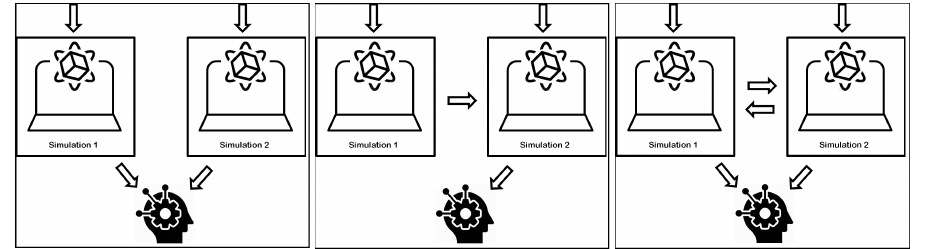
Figure 1. Simulations orchestrations (independent ( left ), sequential ( middle ), and parallel ( right